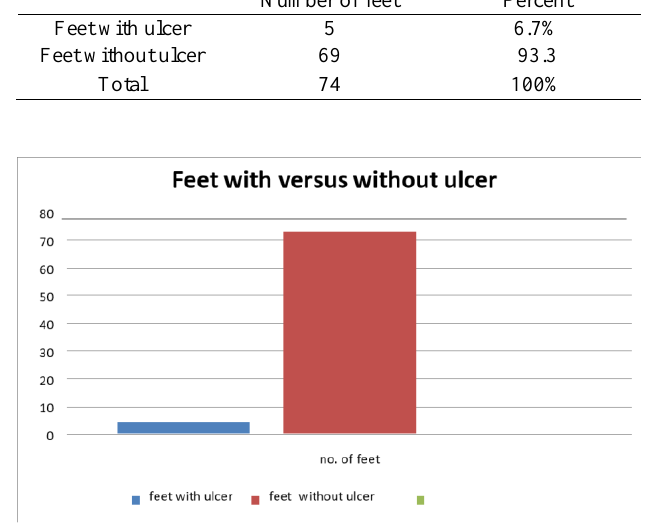
Figure 1: Bar chart showing number of feet who did and didn’t develop